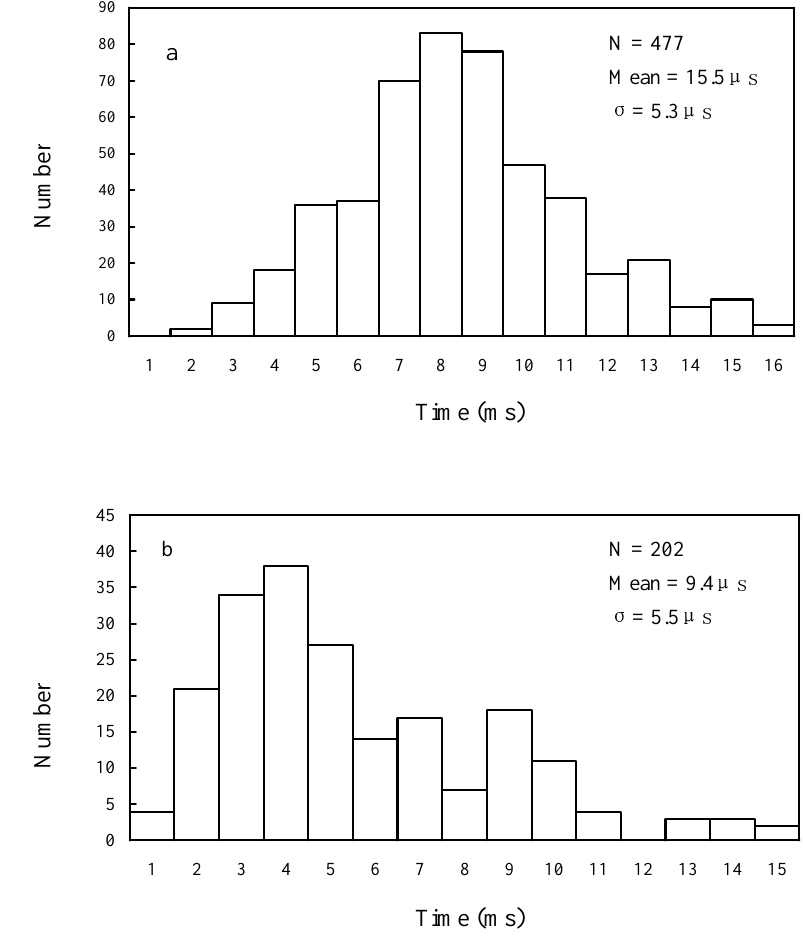
Fig. 4. Histograms of the time interval between successive step pulses, (a) for stepped leader, (b) for dart-stepped leader.